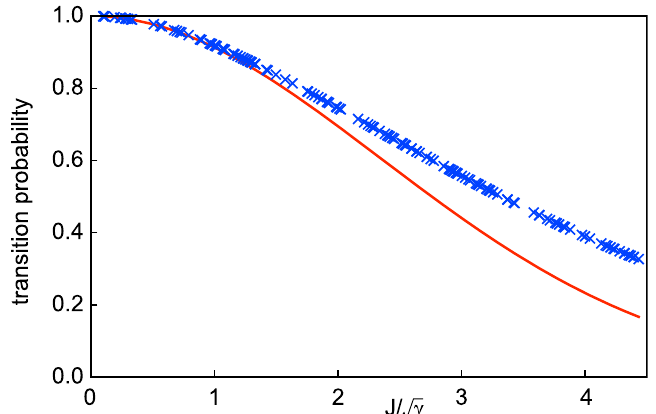
Figure 4: The BE formula in Eq. (47) (red solid line) and the zeroth-order approxi- mation ( × , blue) for ˆ H in Eq. (55). We set N = 10. 3 − body